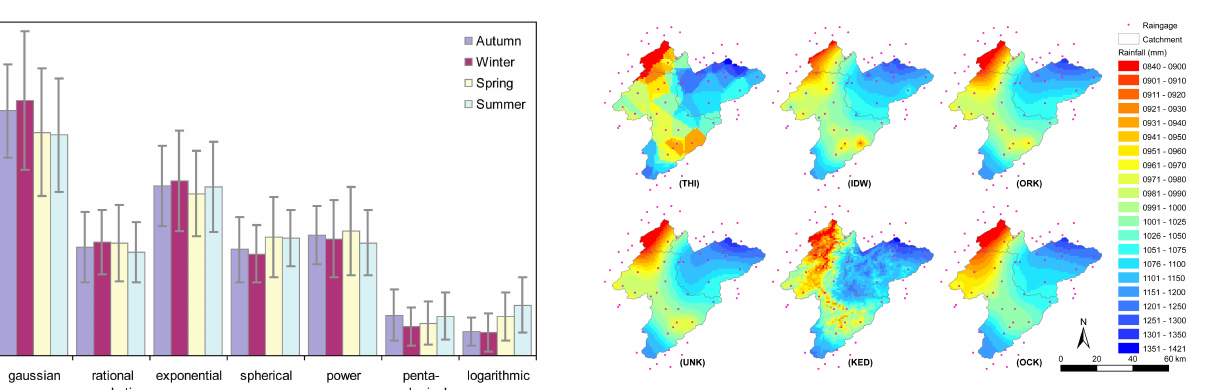
Fig. 6. Occurrence of the different models chosen for each season: bars represent the average percentage of the total number of rainy days and error bars are minus and plus the standard deviation of the 30-yr daily dataset.